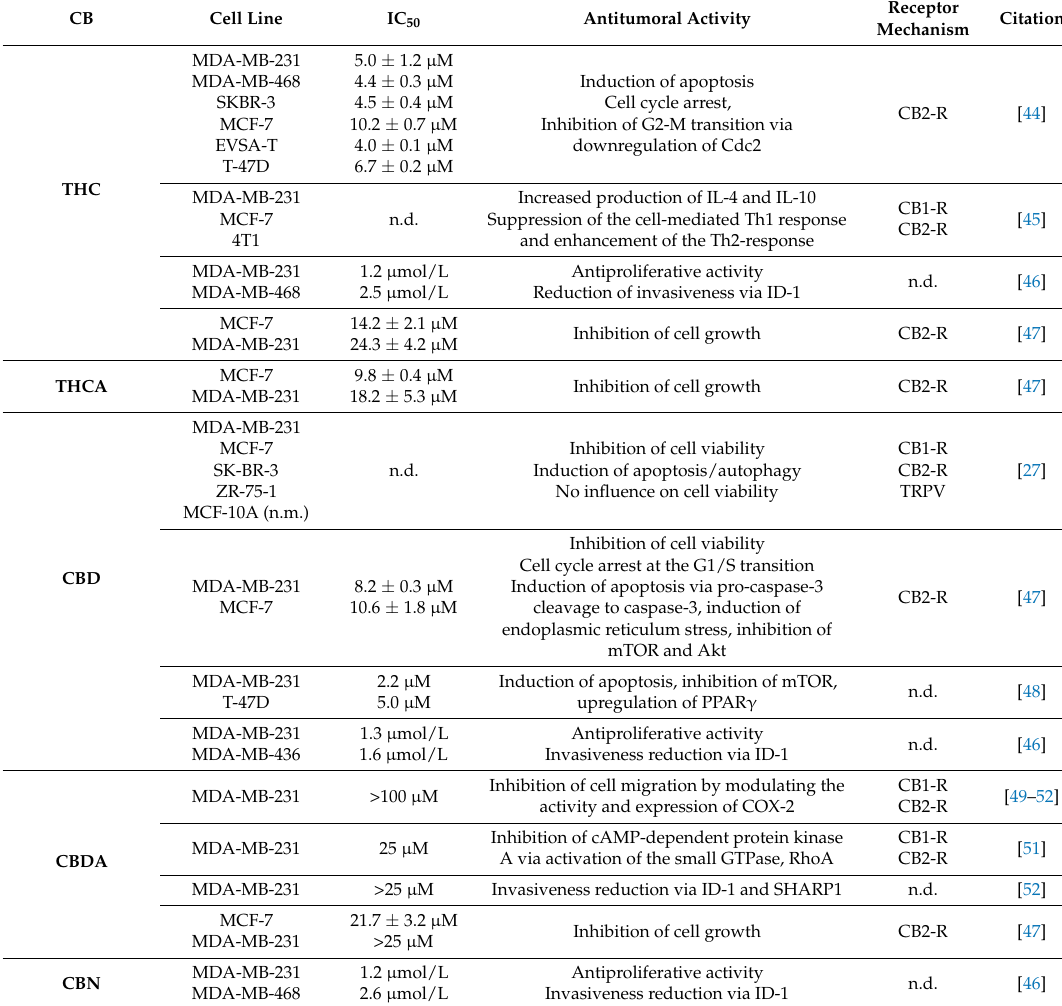
Table 1. Antitumoral activity of CBs in hormone-dependent and –independent breast cancer cell